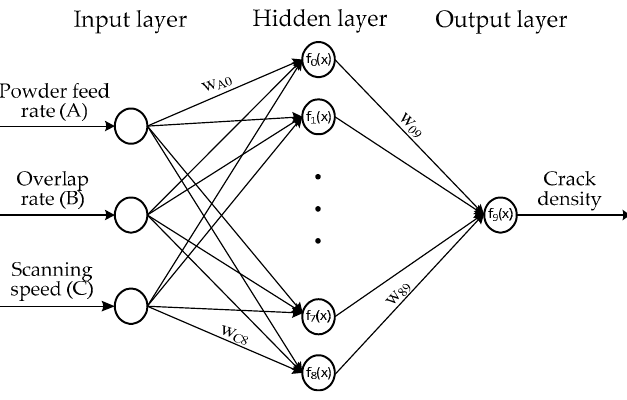
Figure 5. Crack prediction network topology.